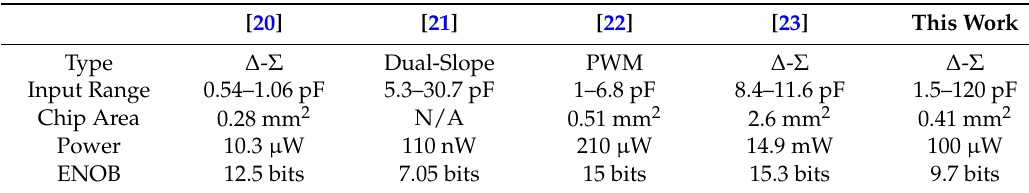
Table 1. A comparison of the performance of the capacitance-to-digital converter used in the present study to those used in previous studies.